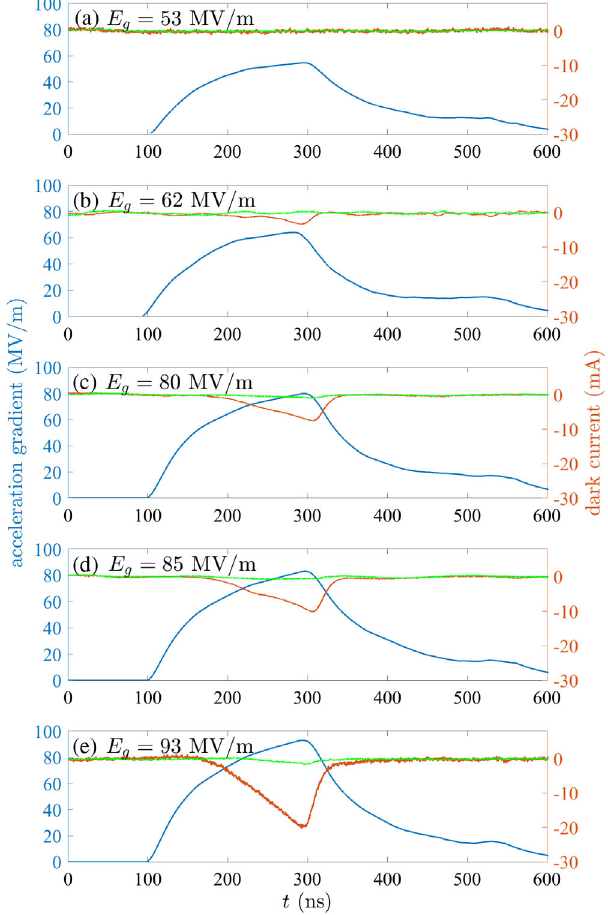
FIG. 13. Sample traces of the gradient (blue), side dark current (green) and downstream dark current (red) measure- ment results at the finishing stage of the E structure condition- ing, for gradients of (a) 53 MV = m, (b) 62 MV = m, (c) 80 MV = m, (d) 85 MV = m and (e) 93 MV = m.